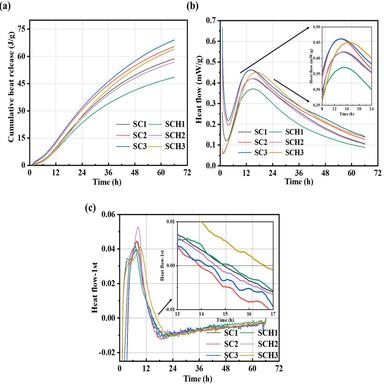
Hydration heat behavior with different activators: (a) Cumulative heat release with different activators; (b) Heat flow with different activators; (c) Heat flow derivation of different activators.